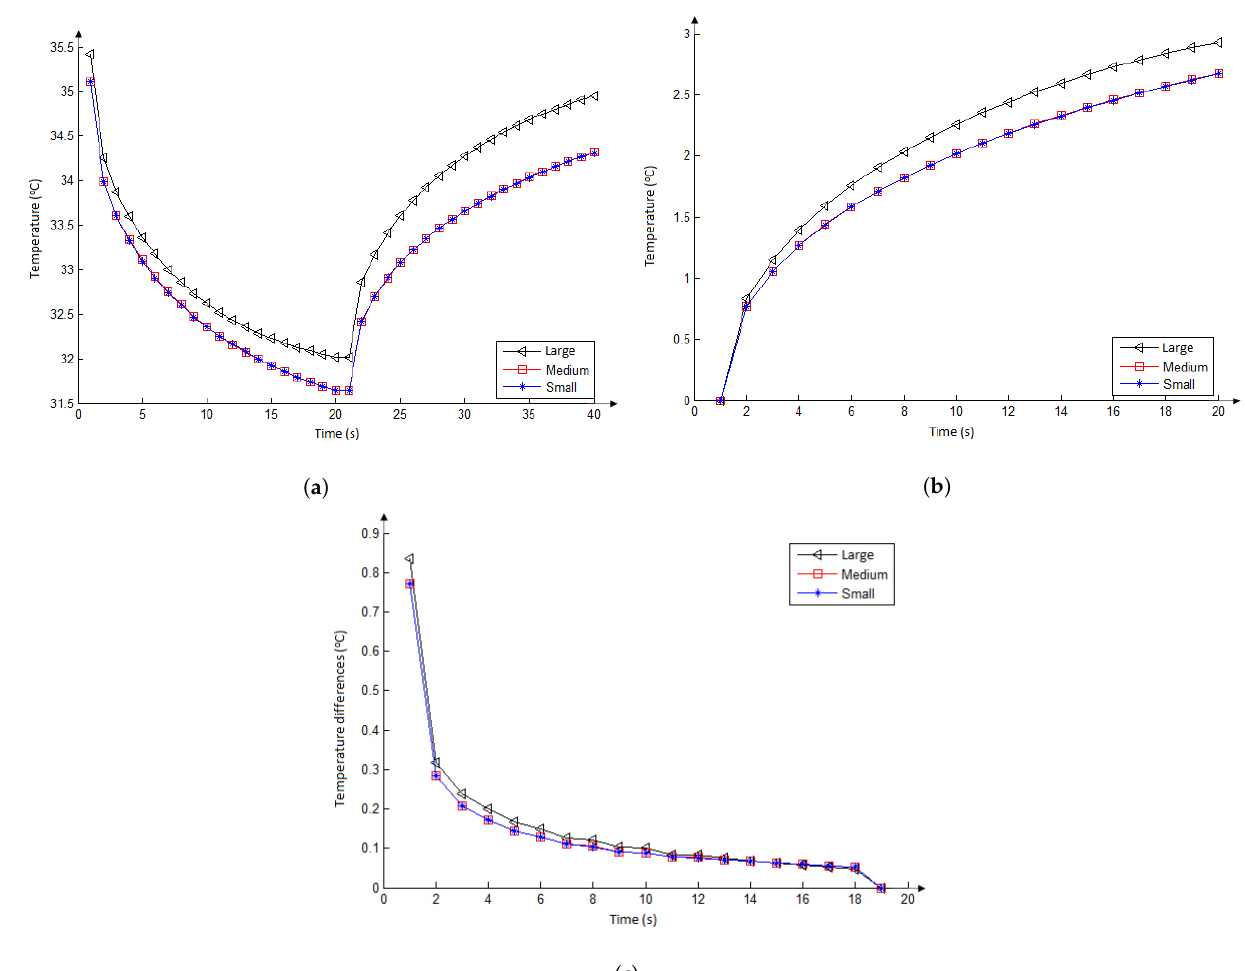
Figure 11. Influence of nodule size in the superficial temperature in front of the nodule considering: All the time of examination in the simulated protocol ( a ) and the natural reheating stage ( b ), where each curve was represented starting with the same temperature for better comparison. Influence of nodule size in the velocity of superficial temperature change, this velocity is related to the differences between two consecutive temperatures ( c